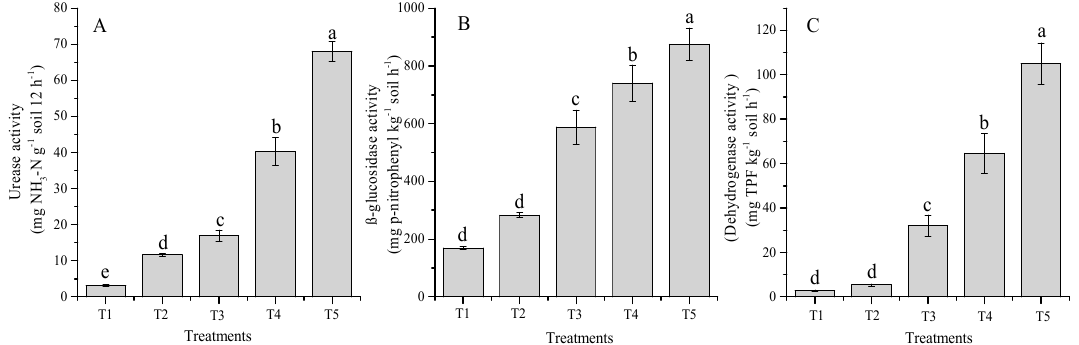
Figure 5. Influences of co-application of TW and chemical fertilizers on soil enzymes activities, urease ( A ), β -glucosidase ( B ) and dehydrogenase ( C ) after wheat harvested. Without amendment (T1), chemical fertilizers (T2), TW 2.5% + F (T3), TW 5% + F (T4) and TW 10% + F (T5). The data showed the mean of three replications, and error bars are standard deviations. Different letters indicate there were significant differences ( p < 0.05) in the LSD means comparisons between the treatments mean.